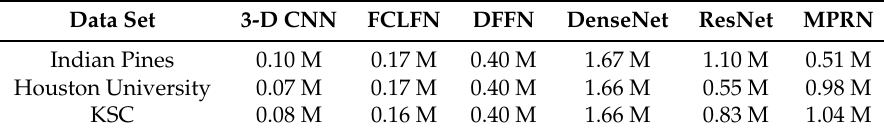
Table 8. Total number of parameters in different models for the three HSI data sets.